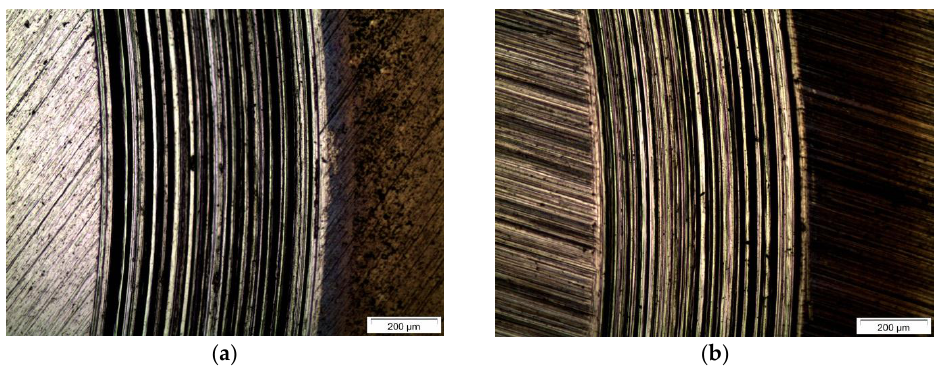
Figure 11. Profile of wear tracks obtained after the polarization curve tests.